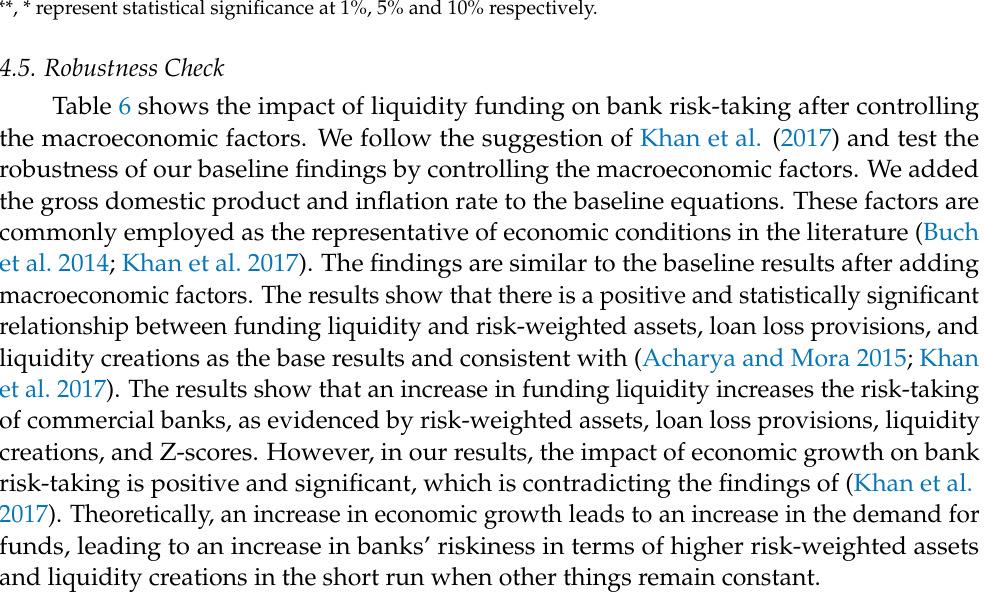
Table 6. Impact of funding liquidity on risk after including macroeconomic